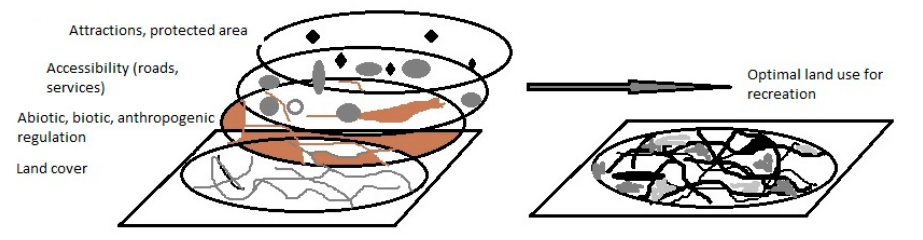
Figure 4. Example of spatial multi-criteria analysis for optimal allocated recreational activity.